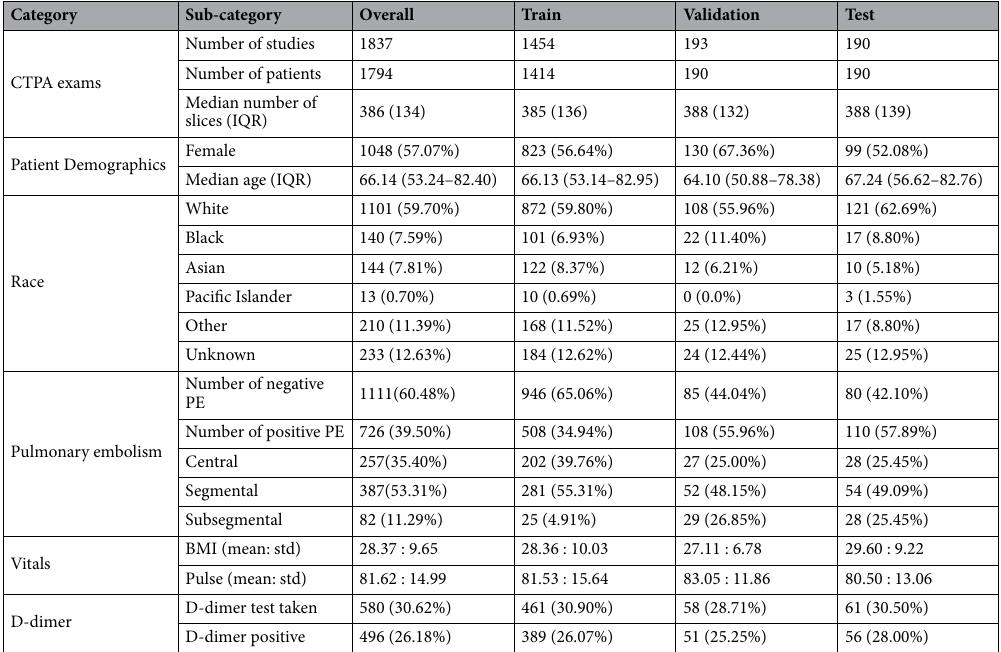
Table 1. Data characteristics of the Stanford Medical Center dataset. The curated Stanford Medical Center dataset was divided into training, validation and test set. The training set was used to optimize model parameters and the validation set was used to select the best model hyperparameters and operating points. The hold-out test set was used to evaluate the model’s